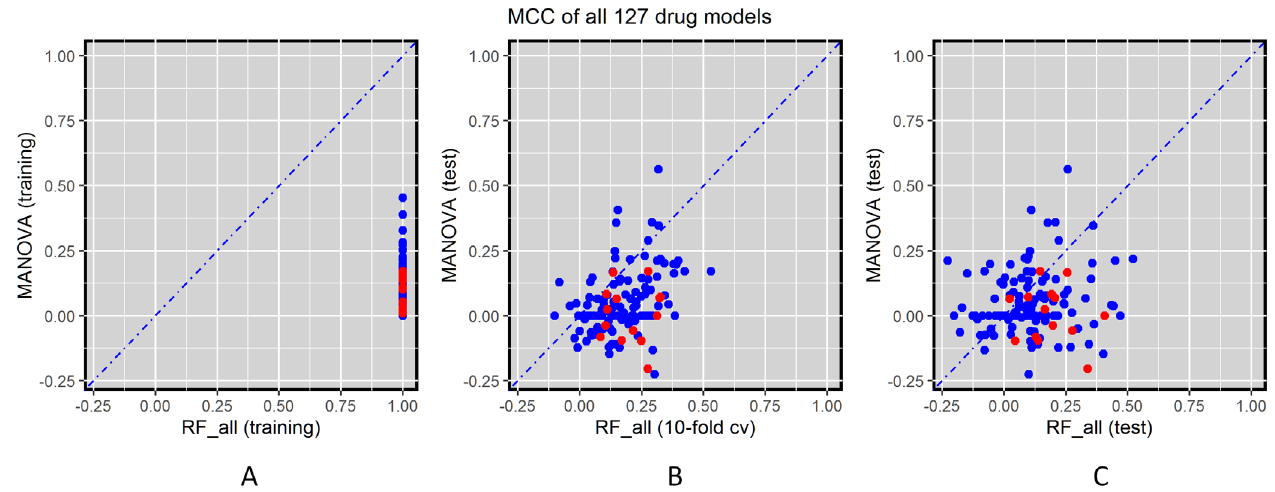
Figure 6. Global performance assessment of single-gene markers versus transcriptomic markers across all 127 drugs. ( A ) Performance assessment on the training data would be strongly biased towards multi-gene markers due to intense overfitting (given the high dimensionality of training data, multi-gene markers obtain maximum (Matthews Correlation Coefficient) MCC for all drugs). ( B ) The performance of single-gene markers on the test set is compared to the 10-fold cross-validated performance of multi-gene markers using training data. The cross-validation is not used for model selection as there is only one Random Forest (RF) model per drug (i.e. no RF control parameter is tuned because the recommended m is used, due to the high dimensionality of each of the 127 classification problems). try However, cross-validation results are substantially better than those from the test set with more recent GDSC data (MCC of 0.18 averaged over the drugs), which suggests time-dependent batch effects 10,42 . ( C ) Using all the comparable data released after the initial GDSC release as a time-stamped test set, 66.1% of drugs are better predicted by the transcriptomic features (this figure is 84.2% using cross-validation). This is the most realistic form of retrospective performance assessment, which leads to the worse results on this challenging problem (MCC of 0.12 averaged over the